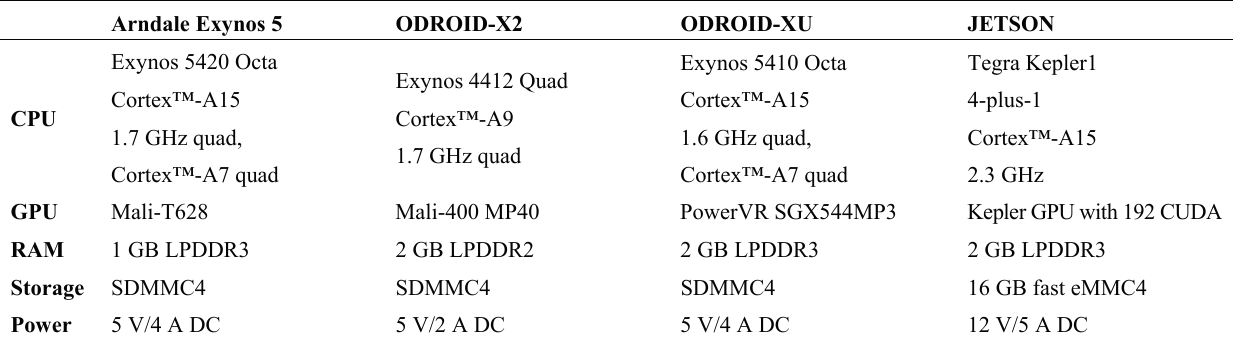
Table 1. Comparison of development board specifications.